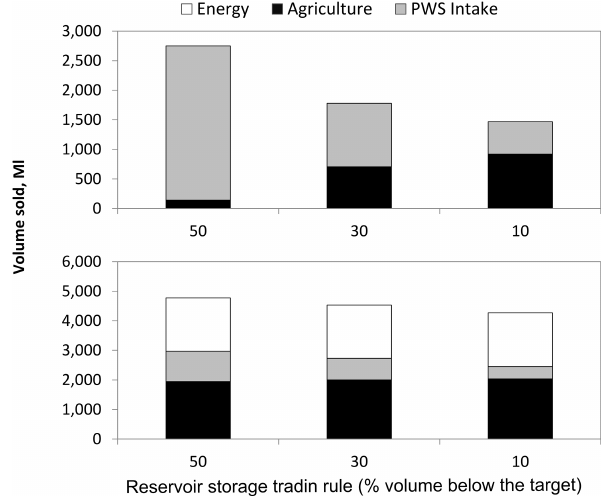
Figure 8. Effect of more conservative PWS trading rule on volumes sold under the current licensing system (top panel) and the proposed system (bottom panel). The water market under the proposed sys- tem is more active and less affected by the change in PWS trading